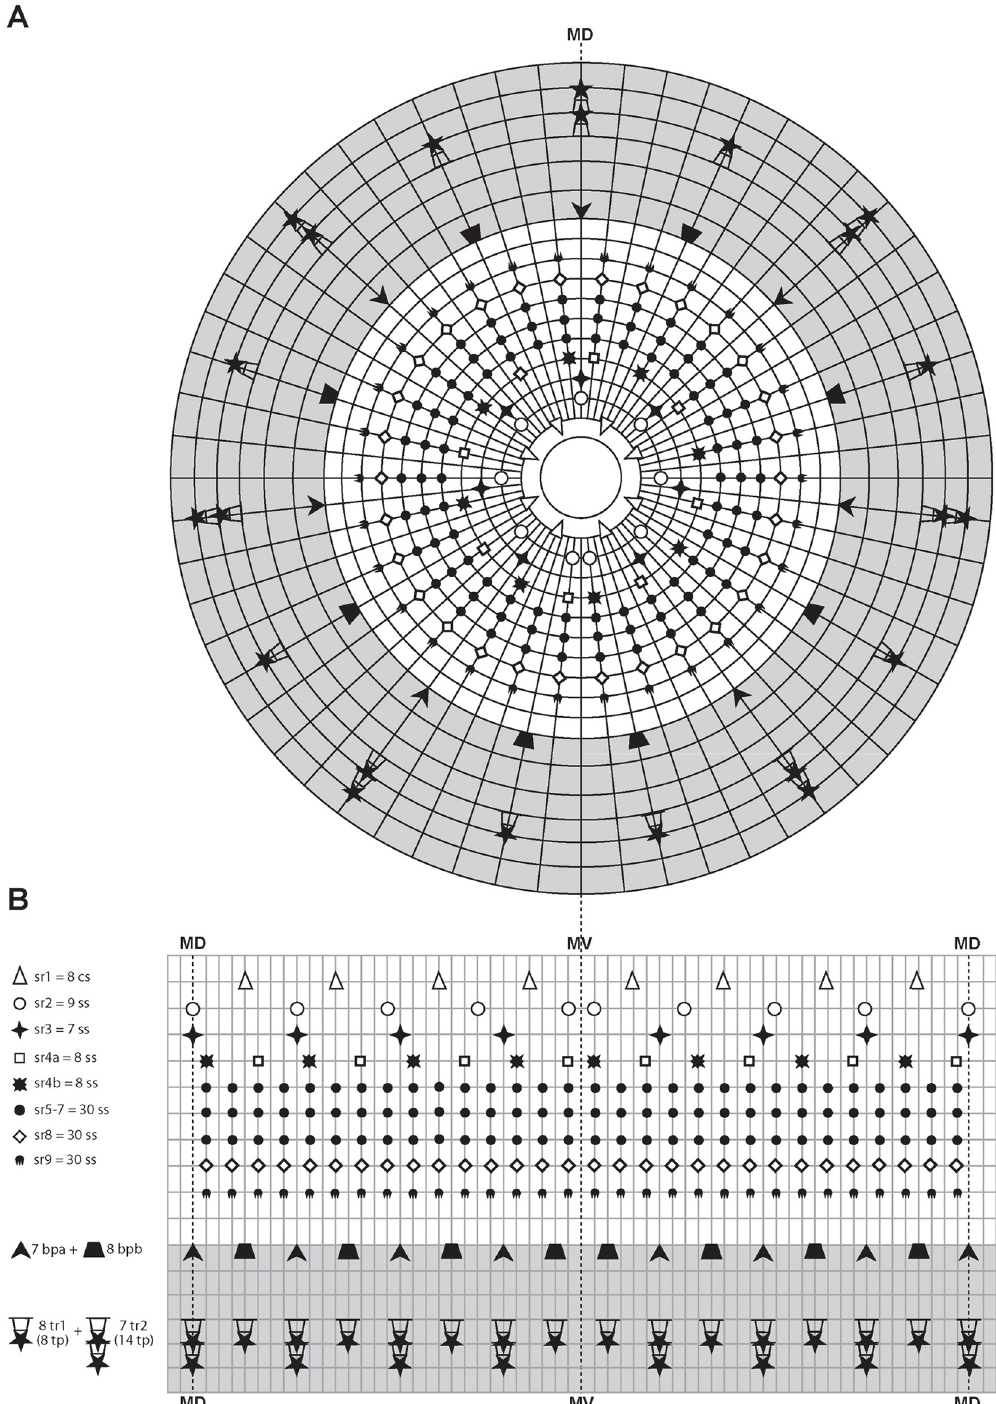
Fig 8. Schematic diagrams of the distribution of introvert and neck appendages in adult forms of Nanaloricus valdemari sp. nov. and Nanaloricus mathildeae sp. nov. Note that for sake of clarity clavoscalid sexual dimorphism is not depicted. Note also that the shaded area indicates the neck region. (A) Polar diagram. (B) Planar projection. Abbreviations: bp a/b , basal plates of type a or b; cs, clavoscalid; MD, middorsal line; MV, midventral line; sr 1–9 , scalids of 1 st to 9 th row; ss, spinoscalid; tp, trichoscalid plate; tr 1 , single trichoscalid; tr 2 , double trichoscalid.